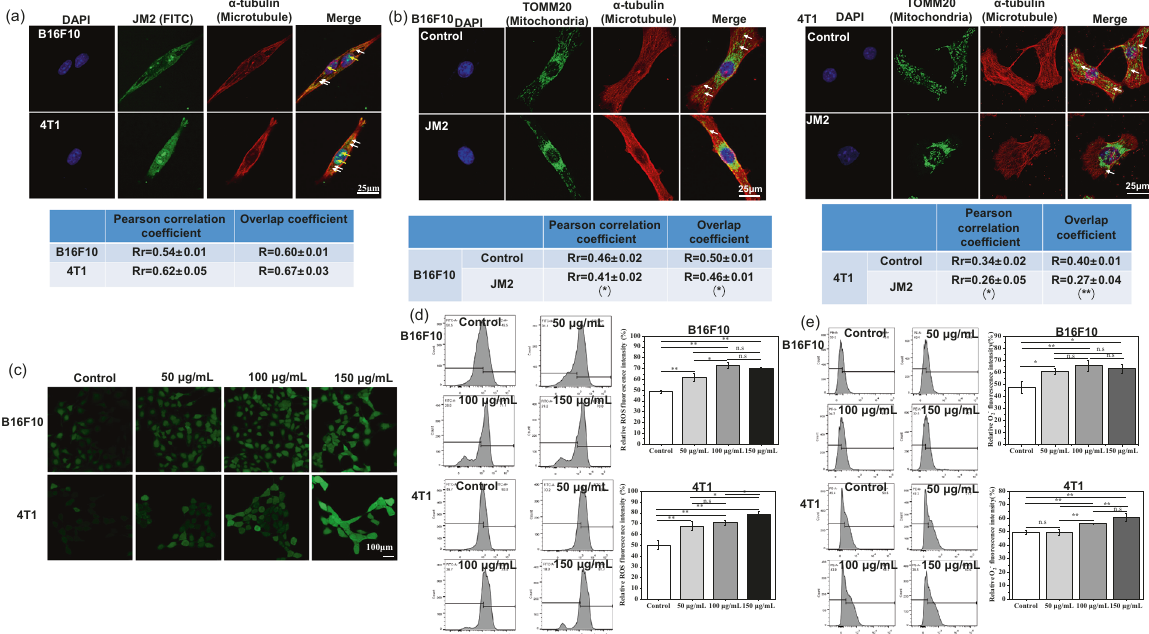
Fig. 4 JM2 induced mitochondrial aggregation and production of ROS. a JM2 located along with microtubules (white arrows) and accumulated in the nuclei of B16F10 and 4T1 cells (yellow arrows). The Pearson correlation coef fi cient (PCC) and the Mander ‘ s overlap coef fi cient (MOC) represented the degree of colocalization between JM2 and microtubules. b JM2 induced the aggregation of mitochondria near the microtubule-organizing center (white arrows). The Pearson correlation coef fi cient (PCC) and the Mander ’ s overlap coef fi cient (MOC) represented the degree of colocalization between mitochondria and microtubules. c Fluorescence images of ROS generated in B16F10 and 4T1 cells. d Quanti fi ed fl ow data of ROS level in B16F10 and 4T1 cells. e Quanti fi ed fl ow data of O2- level in B16F10 and 4T1 cells. * p < 0.05 and ** p < 0.01 when the data was compared with the Control group.